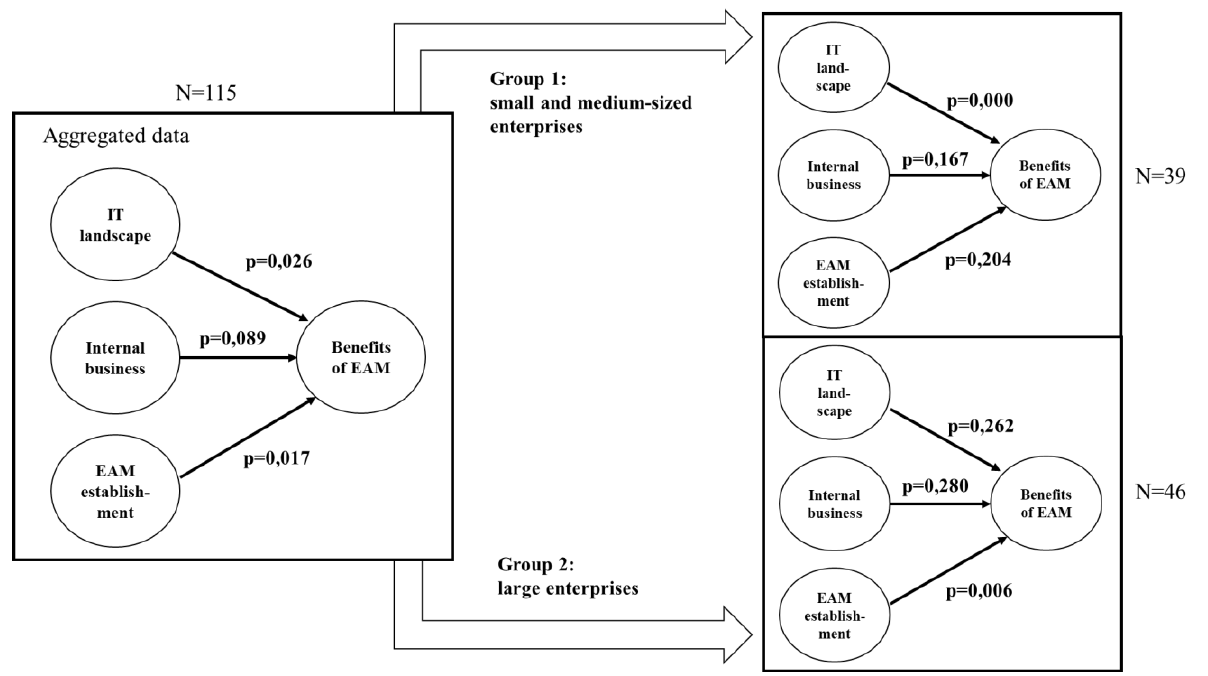
Figure 5. Moderating effect firm size clustered into two